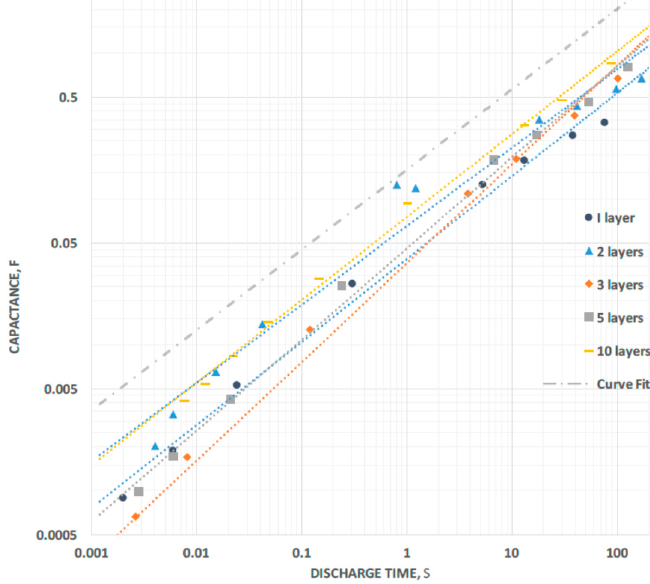
Figure 3. Capacitance vs. Discharge Time. For long discharge time (>100 s) capacitance increases with each additional layer, but for all capacitors, except three-layer, approximately the same simple power relationship (slope) between discharge time and capacitance describes the capacitive roll-off with decreasing discharge time. The dashed curve (above others) is the fit to Equation (1).